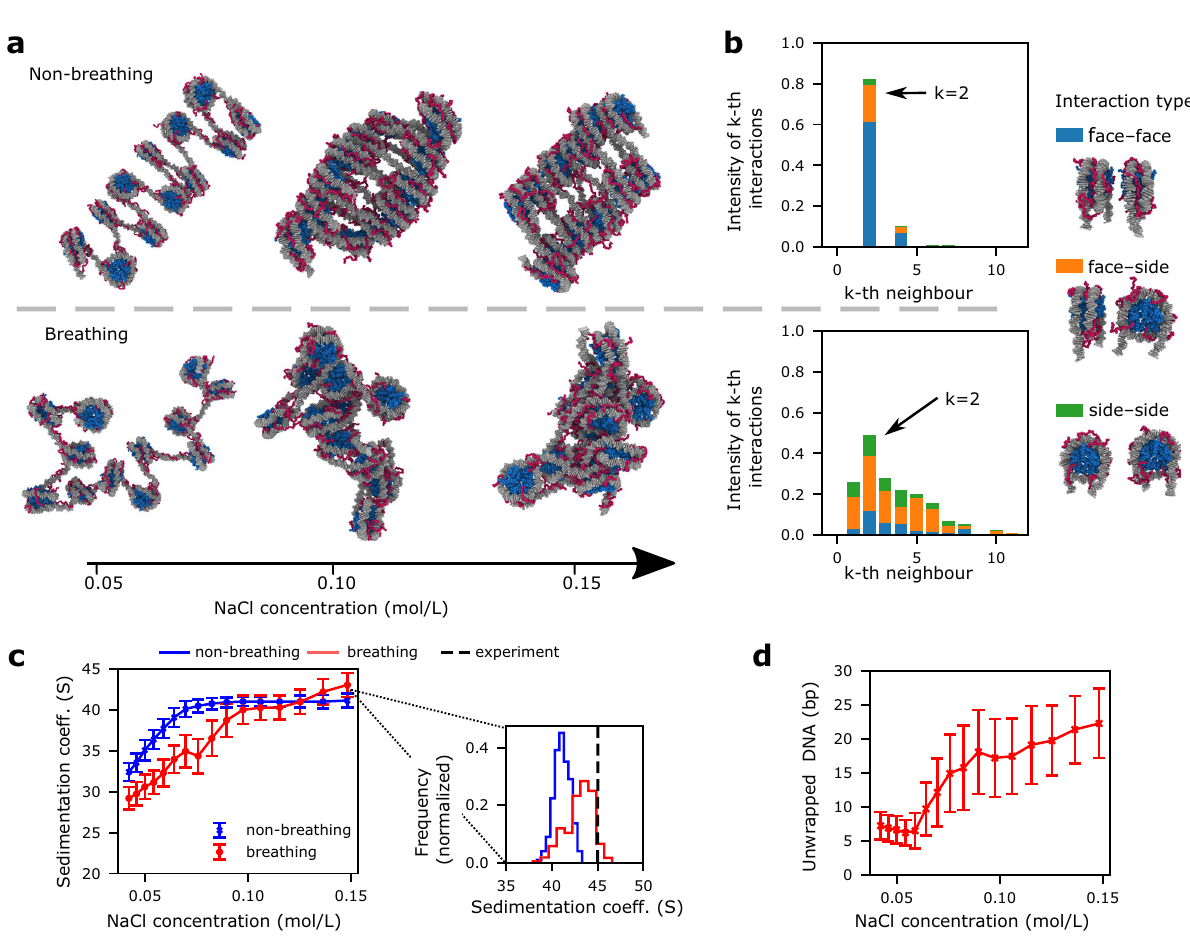
Fig. 3 Structural differences in chromatin arrays with breathing versus non-breathing nucleosomes. a Representative simulation snapshots of 165-bp 12- nucleosome chromatin with non-breathing (top) versus breathing (bottom) nucleosomes at three different salt concentrations: 0.05, 0.10, and 0.15 mol/L of NaCl (color-coded as in Fig. 1 — level 2). b Bar plots depicting the frequency of interactions among k -th nearest nucleosomes neighbors for chromatin with non-breathing (top) versus breathing (bottom) nucleosomes. The bars are colored according to the percentage of the nucleosome pairs that engage in face-to-face (blue), face-to-side (orange), or side-to-side (green) interactions; these types of interactions are illustrated by the cartoons on the right. The de fi nitions of the nucleosome axes used to determine if an interaction occurs face-to-face, face-to-side, or side-to-side are given in Supplementary Fig. 6. c Sedimentation coef fi cients versus NaCl concentration (left) for chromatin with non-breathing (blue) versus breathing (red) nucleosomes. The spread of the data around the mean values, mean ± s.d., are shown as bands; these were obtained by comparing n = 500 independent con fi gurations. Histograms (right) comparing the distributions of sedimentation coef fi cient values for chromatin with non-breathing (blue solid) and breathing (red solid) at 0.15 mol/ L in our simulations with the experimental value from reference 123 (black dashed). d Average number of DNA base pairs that unwrap per nucleosome in our simulations at a varying concentrations of NaCl. The spread of the data around the mean values, mean ± s.d., are shown as bands; these were obtained by comparing n = 500 independent con fi